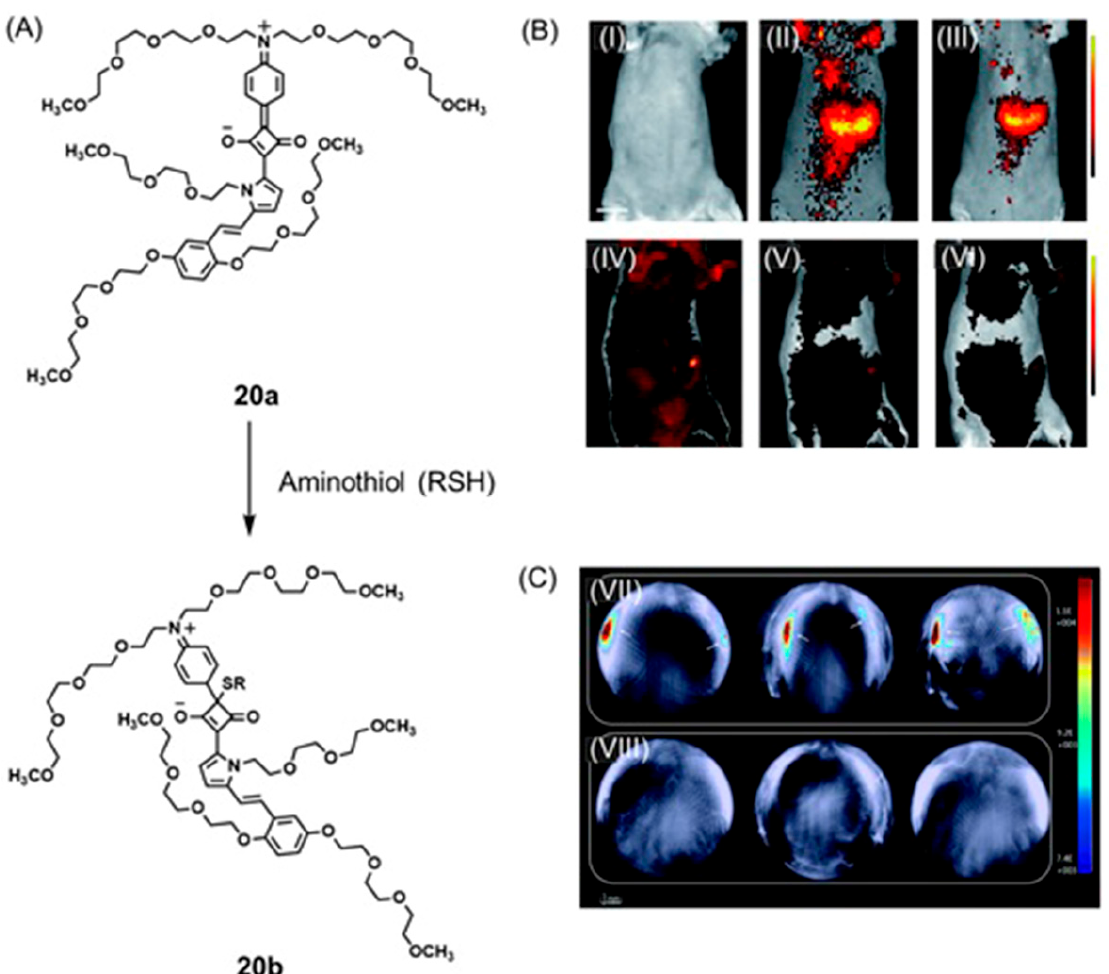
Figure 43. ( A ) Chemical structures and conversion of 20a to 20b in the presence of aminothiols. ( B ) In vivo fluorescence reflectance images from dorsal side of a seven-week-old fasting mouse (top panels) and post-food mouse (bottom panels). (I) pre-injected with 20a in a fasting female mouse at 675 ± 15 nm excitation and 700 ± 10 nm emission. (II) and (III) images were recorded after 15 and 40 min, respectively, of injection of 20a under fasting conditions. Images of mouse in post-food conditions were recorded upon excitation of 675 ± 15 nm and 700 ± 10 nm emission. Images were recorded at (IV) 5, (V) 15, and (VI) 40 min. Scale bar = 1.5 mm. Under fasting conditions, low levels of aminothiols are present in blood. Therefore, strong near-IR fluorescence and photoacoustic signals can be observed during fasting conditions. After food, high levels of aminothiols in blood are observed. Hence, both near-IR and fluorescence signals become weakened. Based on (II) and (III), a strong fluorescence emission indicates effective distribution of 20a in blood and its accumulation in the abdominal area. After feeding, images (IV), (V), and (VI) exhibit weak fluorescence, indicating that thiol production after food was high and as-generated thiols reacted with 20a . ( C ) Single wavelength multispectral optoacoustic images of a live mouse at 680 nm. (VII) Anatomy of the fasting mouse at 40 min post-injection of 20a . (VIII) Anatomy of the mouse under post-food conditions at 40 min post-injection of 20a . White arrows indicate fluorescence signals from 20a . Adapted from Ref. [351] with permission from the Royal Society of Chemistry.